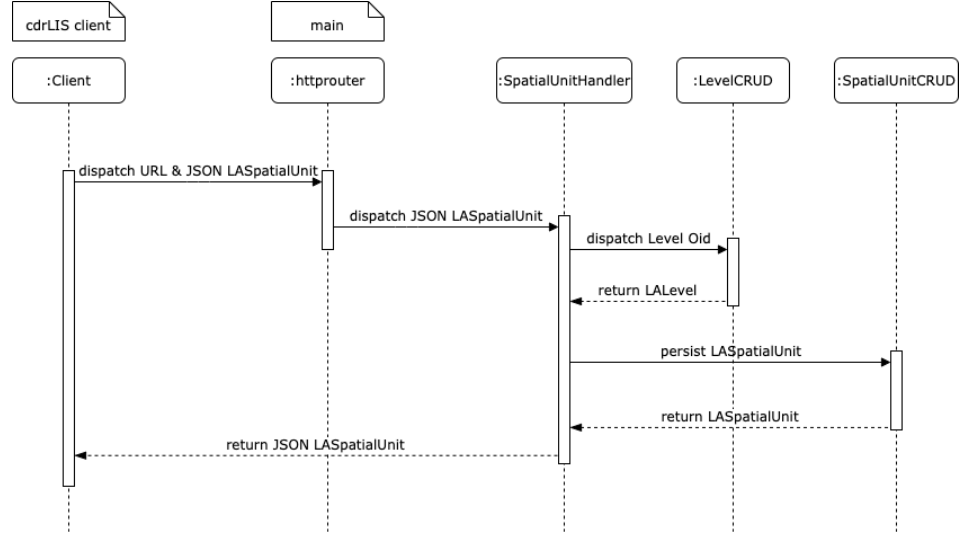
Figure 2. UML sequence diagram: creation of